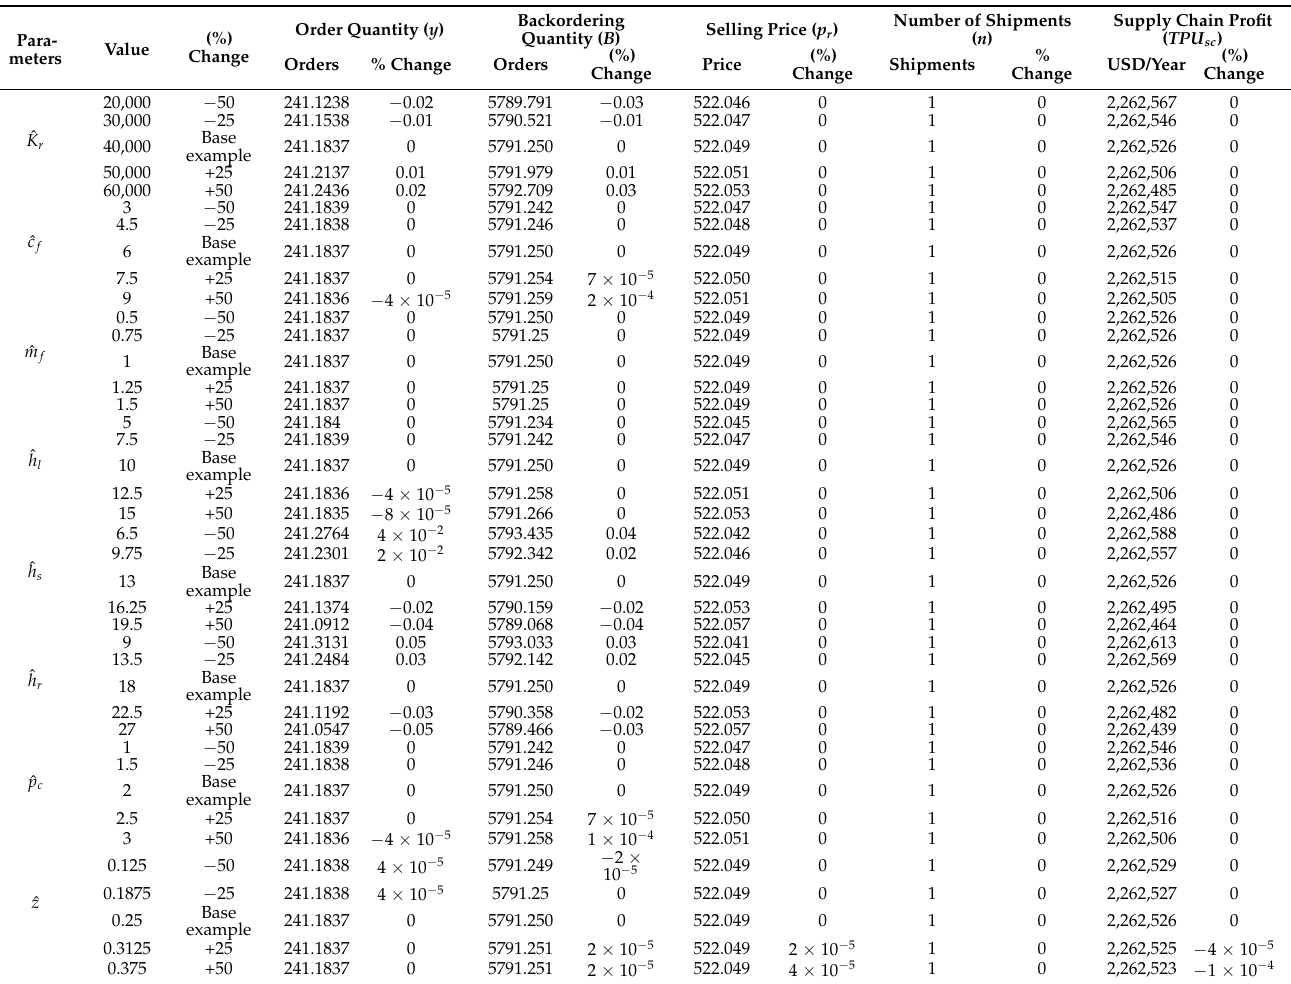
Table 7. Impacts of the carbon emissions parameters optimal